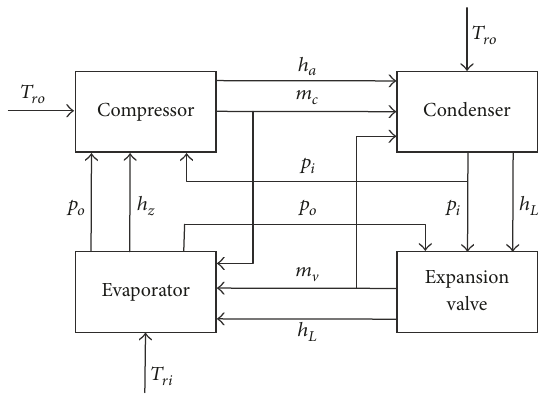
Figure 1: The coupling.